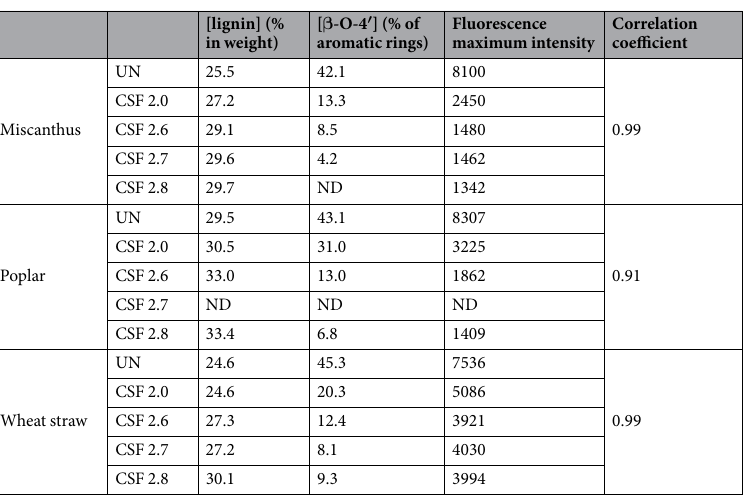
Table 3. Content in lignin and β -O-4 ′ inter-unit cross-linkages of untreated (UN) and pretreated samples (from ref. 32) and correlation coefficient between [ β -O-4 ′ ] and fluorescence maximum intensity (from Table